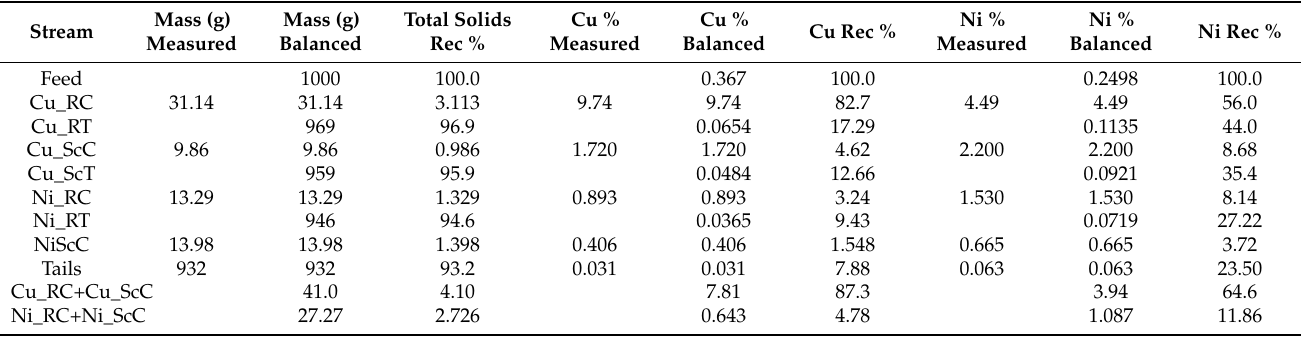
Table A4. Mass balance for flotation test Sep 10_02.